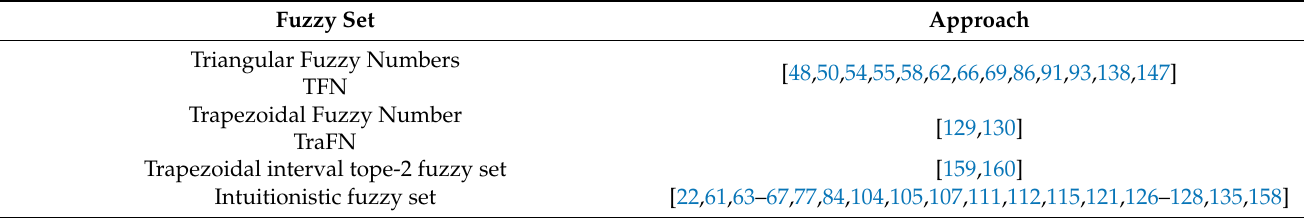
Table A7. Summary of fuzzy sets fuzzy sets applied in fuzzy AHP. Fuzzy Set